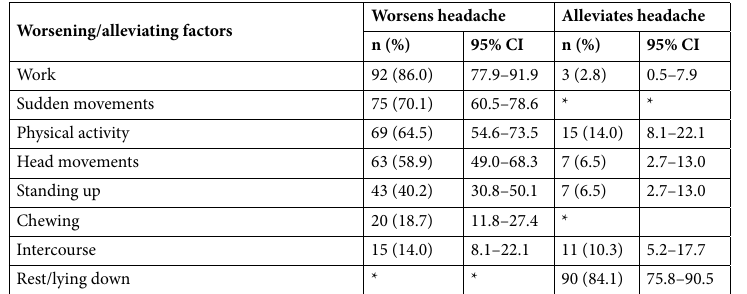
Table 3. Headache characteristics approximately 4 months after mild traumatic brain injury. CI confidence interval, SD standard deviation, VAS visual analogue scale. *< 3